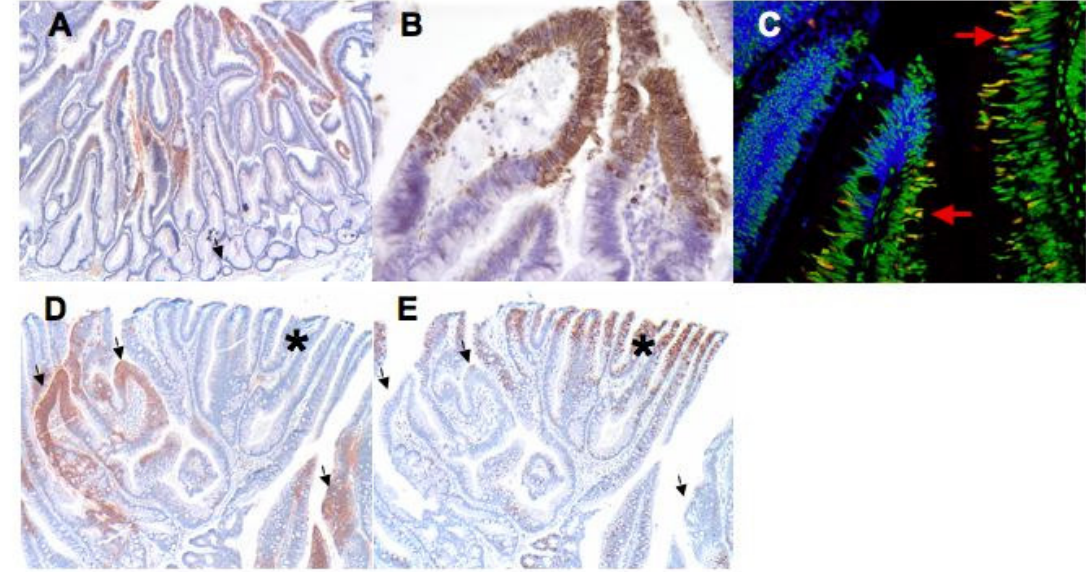
FIGURE 2 . Aberrant staining pattern of Lgr5 in colonic adenoma. (A) Patchy staining of Lgr5 (10 × ). Minimal staining was observed at the crypt base (arrow). (B) Staining of Lgr5 at surface with a sharp transition relative to nonstaining cells (20 × ). (C) Coimmunofluorescence of Lgr5 with Cy5 (blue) and Ki67 with Alexa Fluor 568 (red) (20 × ). Nuclei (green) are stained with SYBR Green Nucleic Acid Stain. There is minimal Ki67 immunostaining in the Lgr5 + cells (blue arrow) compared with neighboring Lgr5 - cells (red arrows). (D) Adjacent section stained for Lgr5 (10 × ). (E) Adjacent section stained for Ki67 (10 × ). Notice the relatively decreased staining of Ki67 in Lgr5 + cells (arrows) and relatively increased staining of Ki67 at the surface where Lgr5 staining is minimal